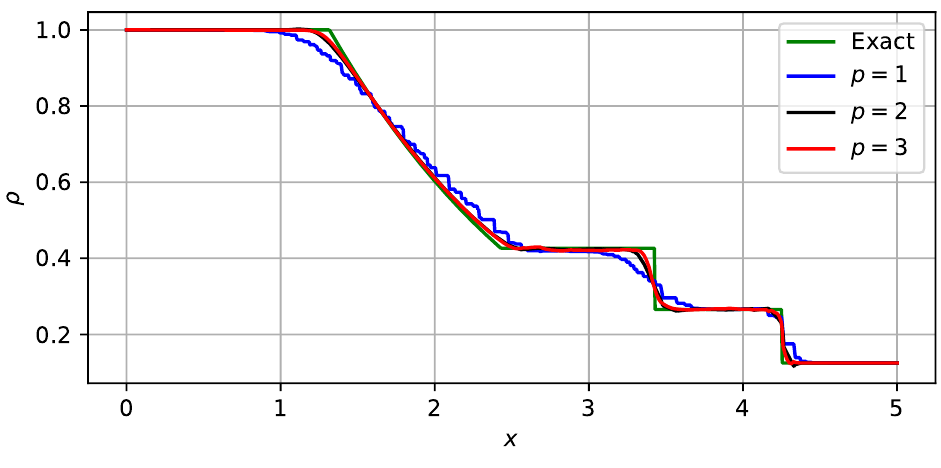
Figure 2. Comparison between solutions of ρ ( t = 1.0 ) in Problem 1.